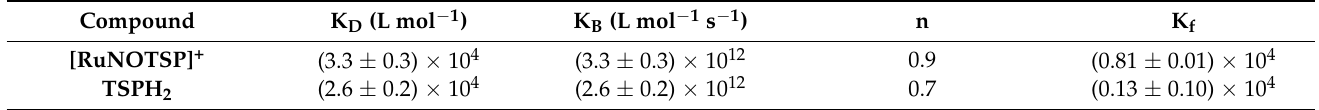
Figure 6. ( a ) Stern–Volmer plot for the observed fluorescence enhancement of [RuNOTSP] + and TSPH 2 upon addition of ctDNA; ( b ) plot of log (I − I 0 )/I vs. log [DNA]. Table 3. Dynamic enhancement, bimolecular enhancement, formation constants, and number of